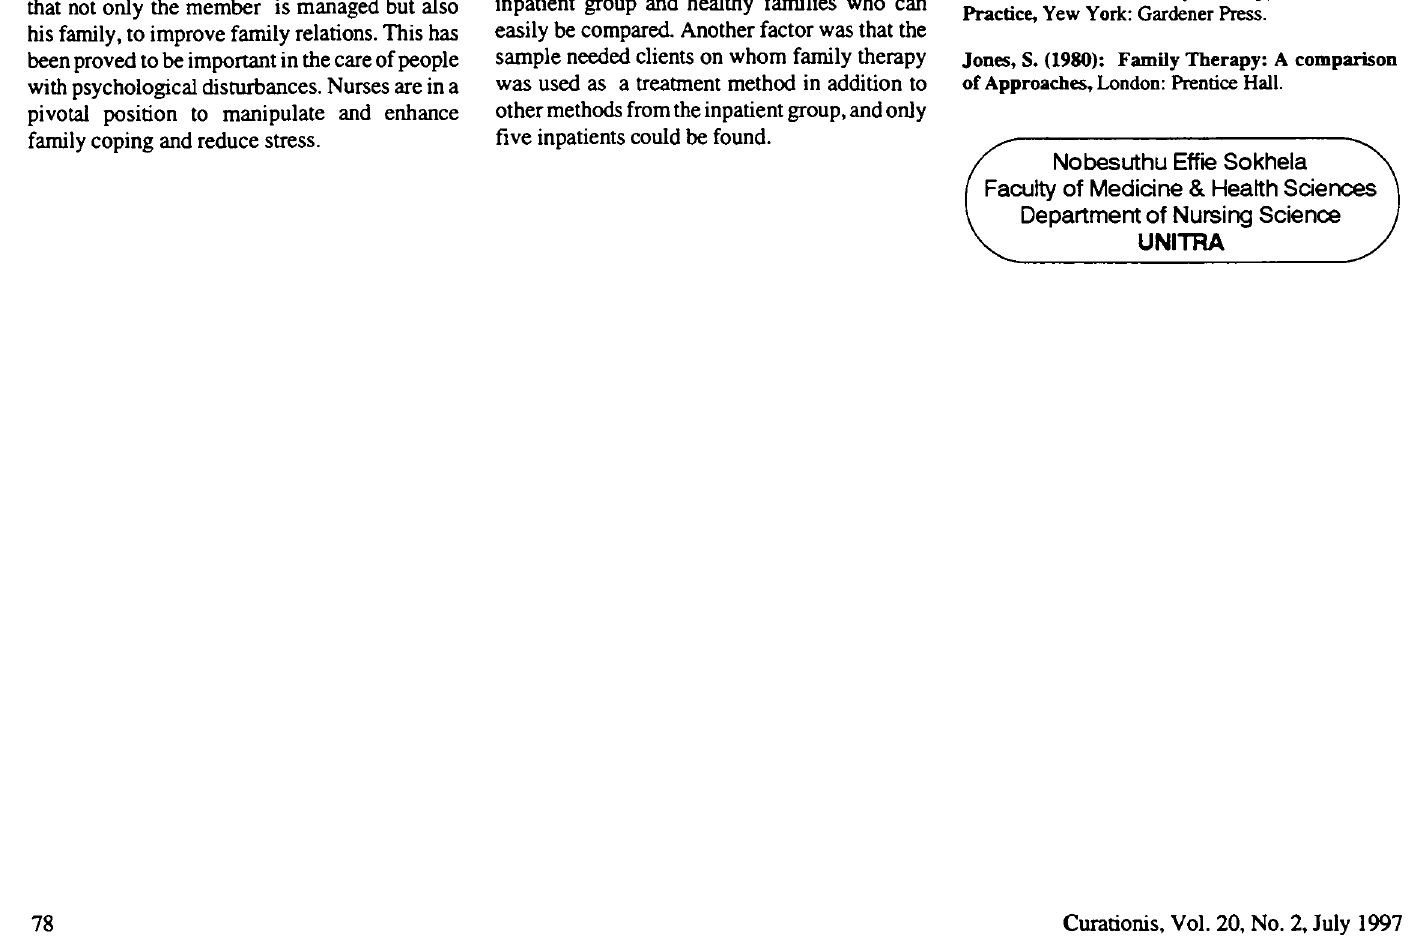
Table A: Results showing differences in the utilization of concepts by healthy families and problem families